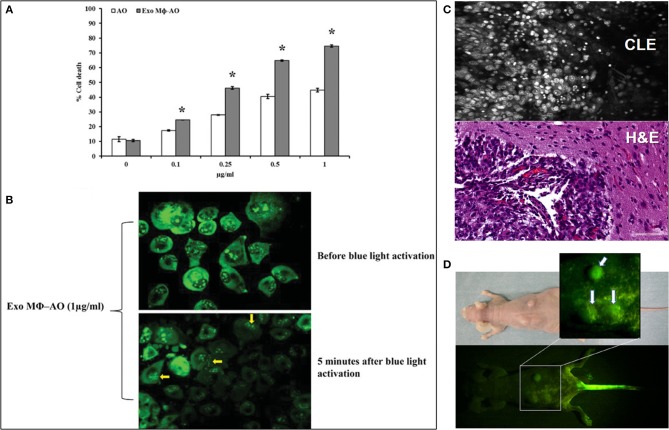
(A) Cytotoxic effect of acridine orange (AO)-charged exosomes derived from macrophages (Exo Mϕ-AO) compared to free AO against melanoma cell monolayer by cytofluorimetry assessment. Columns, mean percentages of cell death of two independent experiments run in triplicate; bars indicate standard deviation. p < 0.05. Figure adapted with permission from: Iessi et al. (43) (CC BY 4.0). (B) Fluorescence microscopy showing the formation of membrane “blebs” in melanoma cells treated with Exo Mϕ-AO (1 lg/ml) after 5 min of exposition to blue light. Figure adapted with permission from: Iessi et al. (43) (CC BY 4.0). (C) Upper image—Confocal laser endomicroscopy image of an animal glioblastoma stained with AO. Lower image—corresponding histology image. Image courtesy of Dr. Mark C. Preul. (D) Macroscopic fluorescence view of mouse osteosarcoma subcutaneously inoculated in the back of nude mouse after blue light excitation at 2 h after AO injection through the tail vein. Tumors emit green fluorescence (arrows). Injection site of the tail vein also emits green fluorescence Figure adapted with permission from: Kusuzaki et al. (6) (CC-BY 3.0).